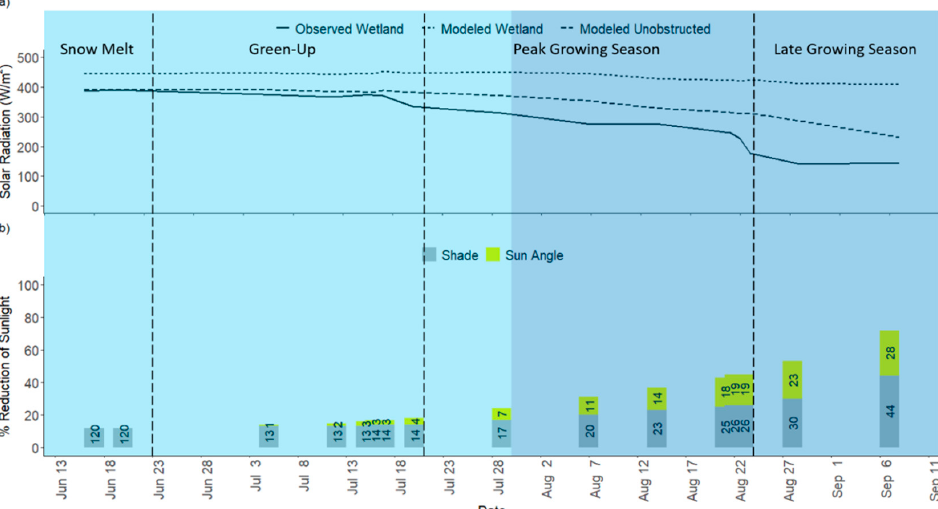
Figure 6. ( a ) Observed incoming solar radiation at the wetland (solid line), modelled incoming solar radiation at the wetland (dashed line) and modelled solar radiation atop Fortress Ridge (dotted line); and ( b ) the relative contribution of horizon shade and seasonality (changes in sun angle over time) to the reduction of incoming shortwave radiation at the study site. The light blue vertical highlighted area represents the Stable Shade period of our study and darker blue vertical highlighted area the Dynamic Shade period.